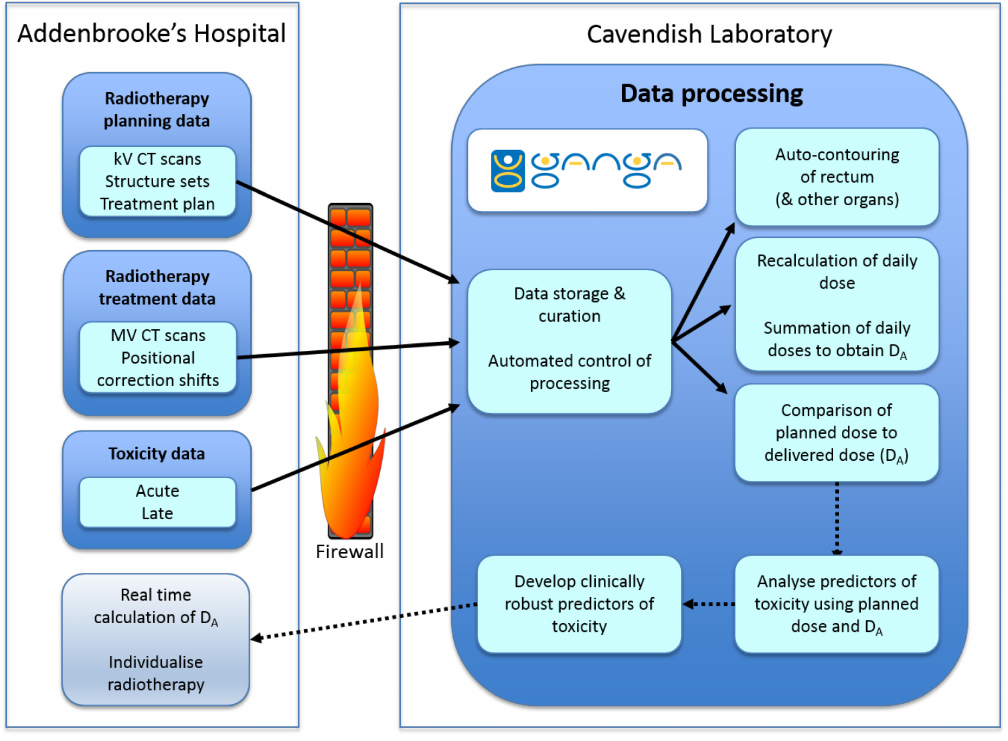
Fig. 2. VoxTox data flows. kV, kilovoltage; MV, megavoltage; D A Accumulated